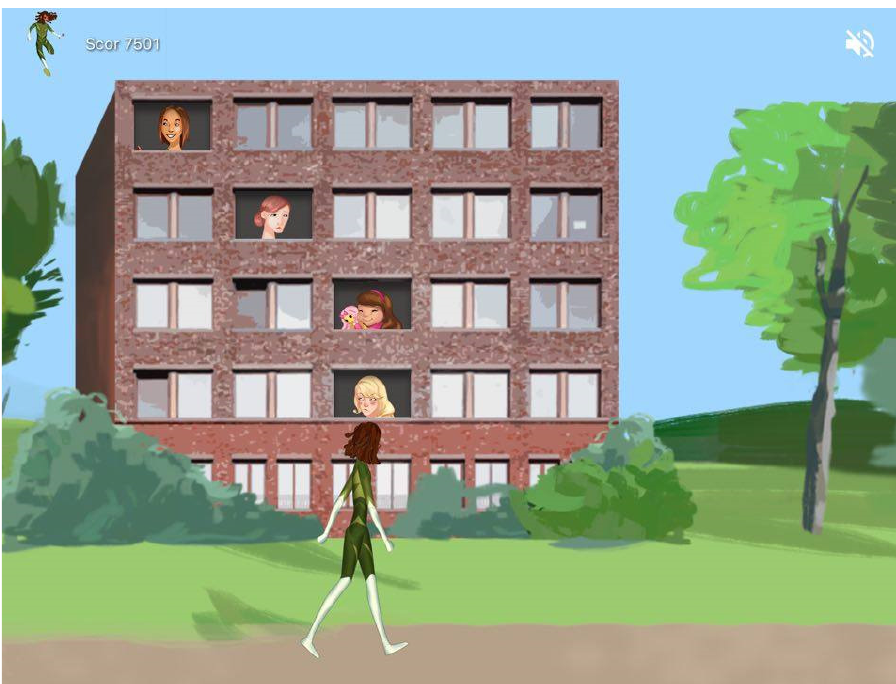
Figure 2. Illustration of the attentional bias training